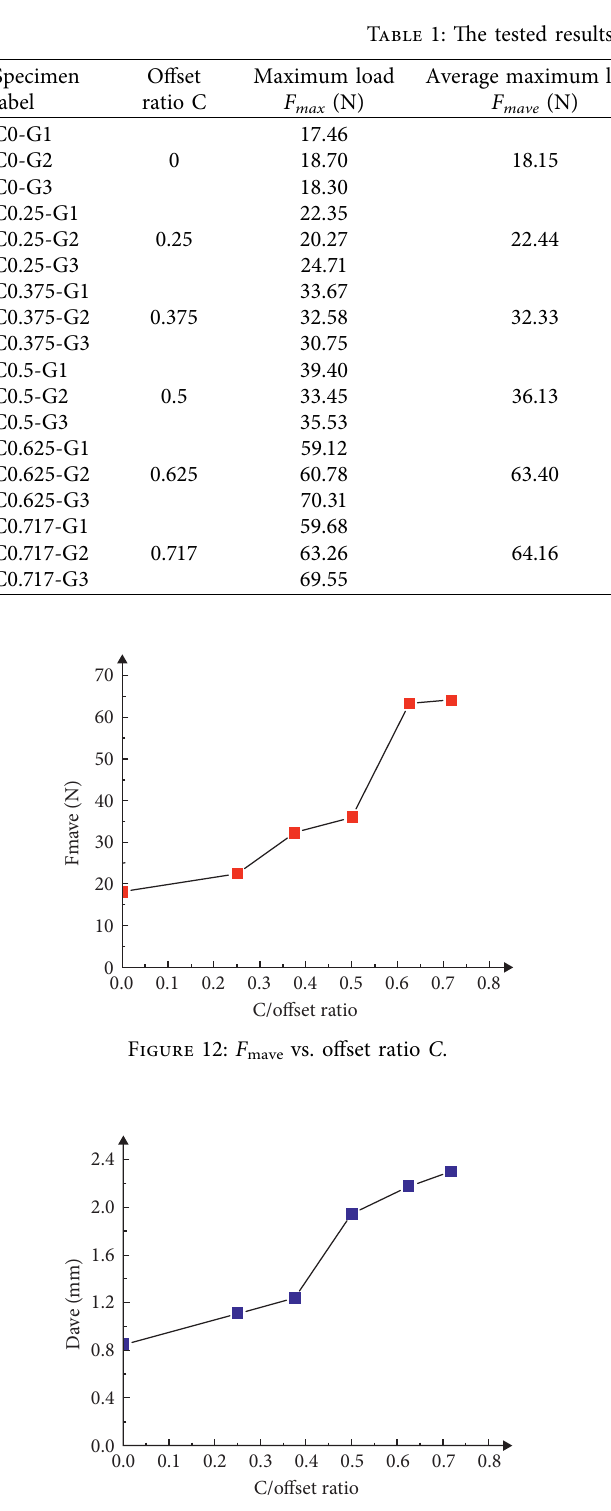
Figure 13: D ave vs. offset ratio C